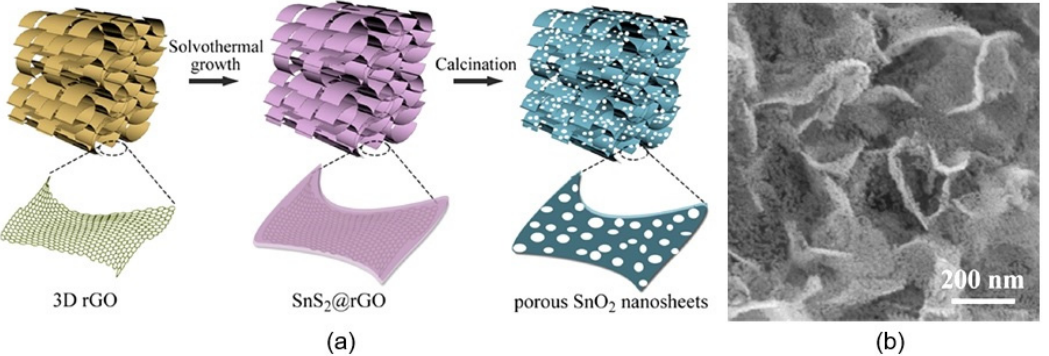
Figure 11. ( a ) Schematic diagram of the synthesis procedure and (b ) SEM image of porous SnO 2